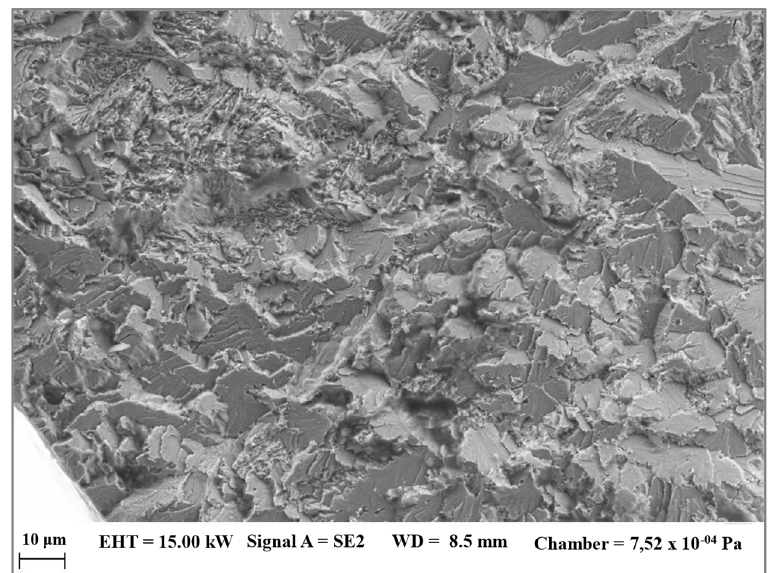
Figure 16. Crack initiation in the metallic matrix and limited fatigue propagation.